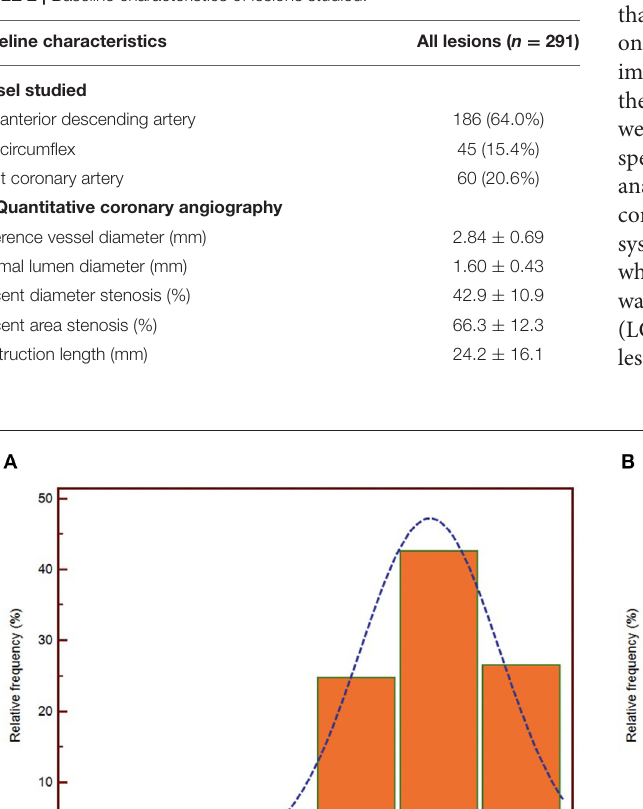
TABLE 2 | Baseline characteristics of lesions studied.